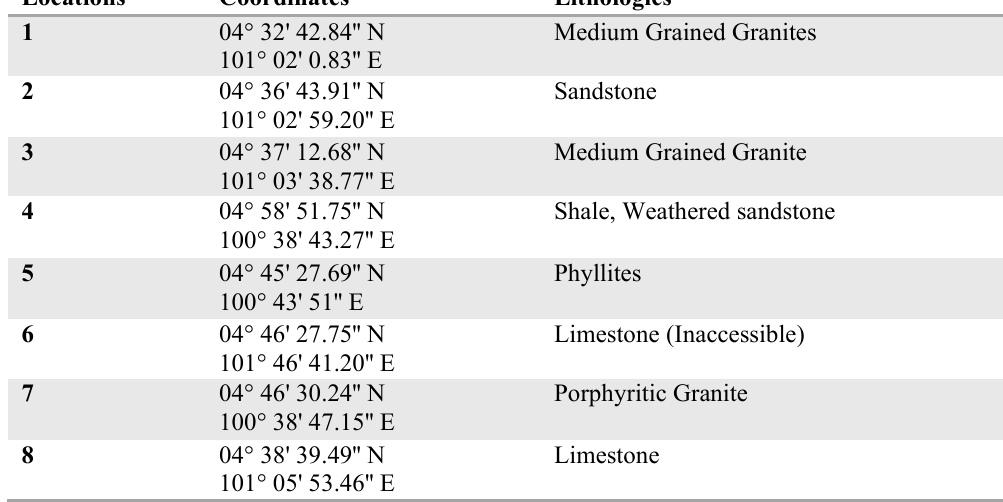
Table 2: Locations and coordinates of lithologies along the Taiping to Ipoh segment of the Highway